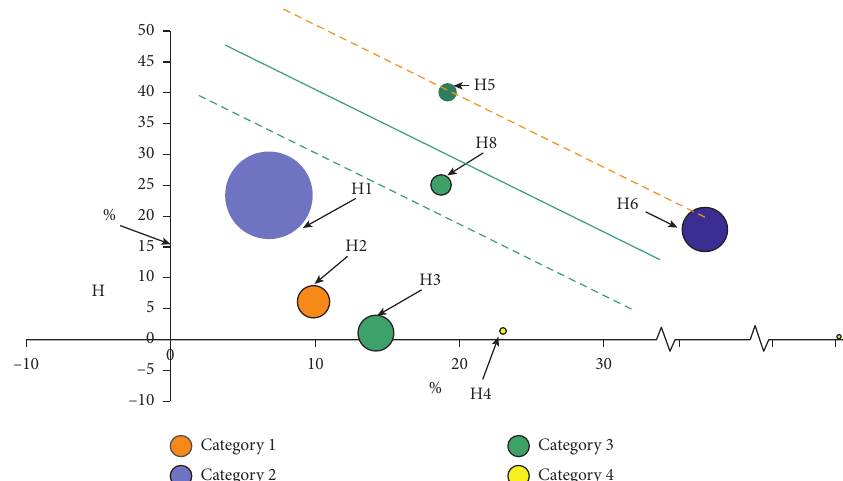
Figure 4: Optimal classification surface in the case of linearly